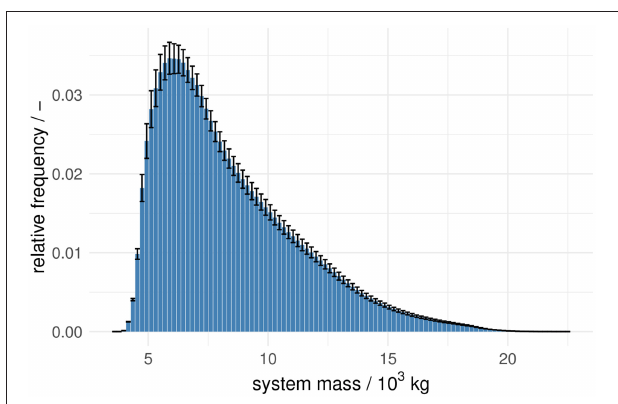
FIGURE 8 | Averaged relative frequencies of the minimized system mass with corresponding standard deviations given as error